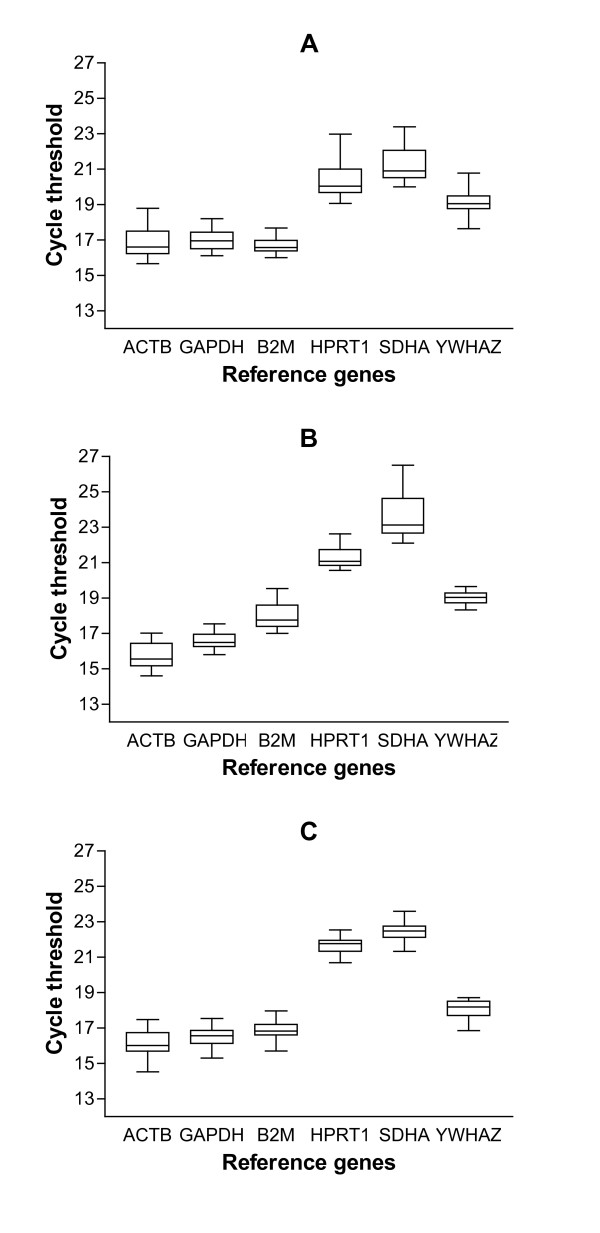
qPCR cycle threshold values of 6 reference genes among 7 culture conditions (table 2). Distribution of expression levels of ACTB, GAPDH, B2M, HPRT1, SDHA, and YWHAZ in IL-1β treated C-28/I2 chondrocytes under the influence of glucosamine (A), curcumin (B) and diacerein (C) is shown as medians (lines), 25th percentile to the 75th percentile (boxes) and ranges (whiskers) (n = 63). Samples were normalized to the amount of total RNA.